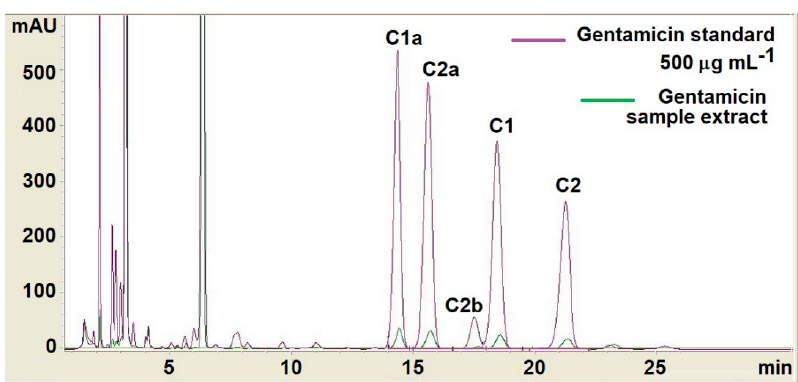
Figure 2. Overlapped chromatograms of a derivatized solution of 500 µg/mL gentamicin standard solution and a gentamicin sample extract .